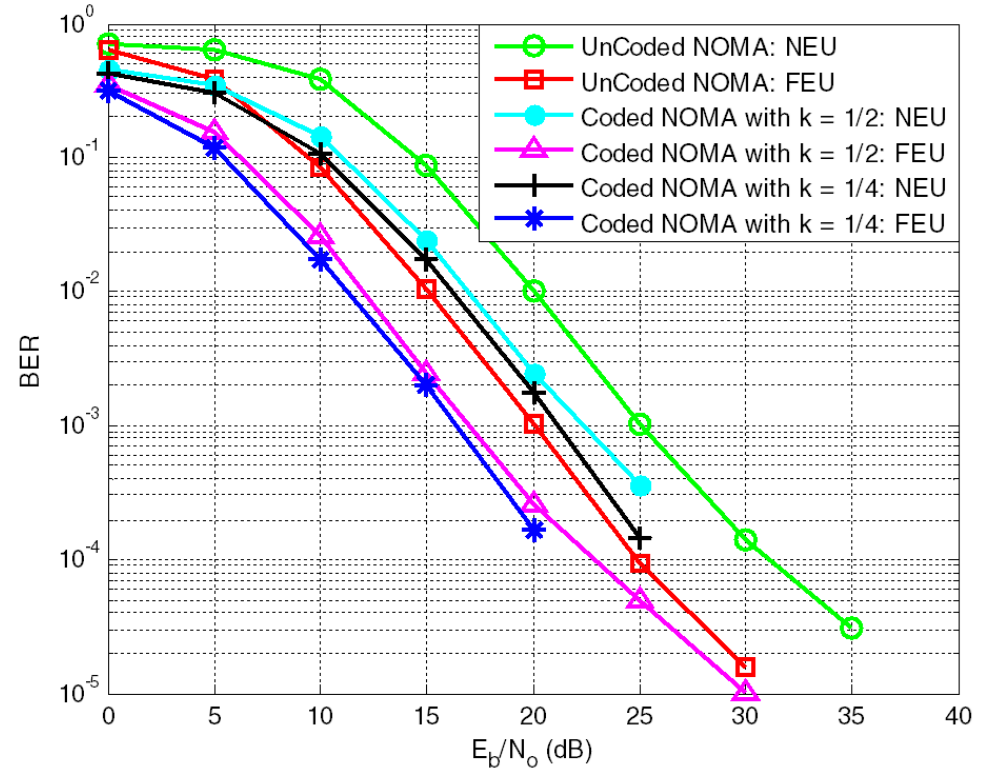
Figure 7. BER comparison of uncoded and coded NOMA for NEU and FEU with perfect SIC in the presence of AWGN and Rayleigh fading